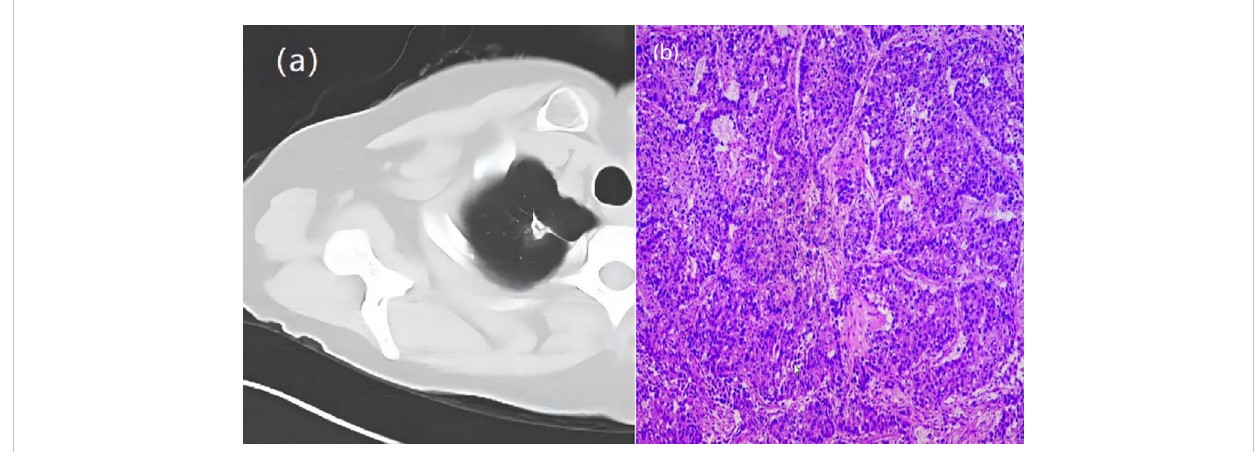
FIGURE 2 A 66-year-old woman with a GGN. CT showed lobulation, pleural traction, burr. (A) Chest scan. (B) pathologically con fi rmed for IAC.